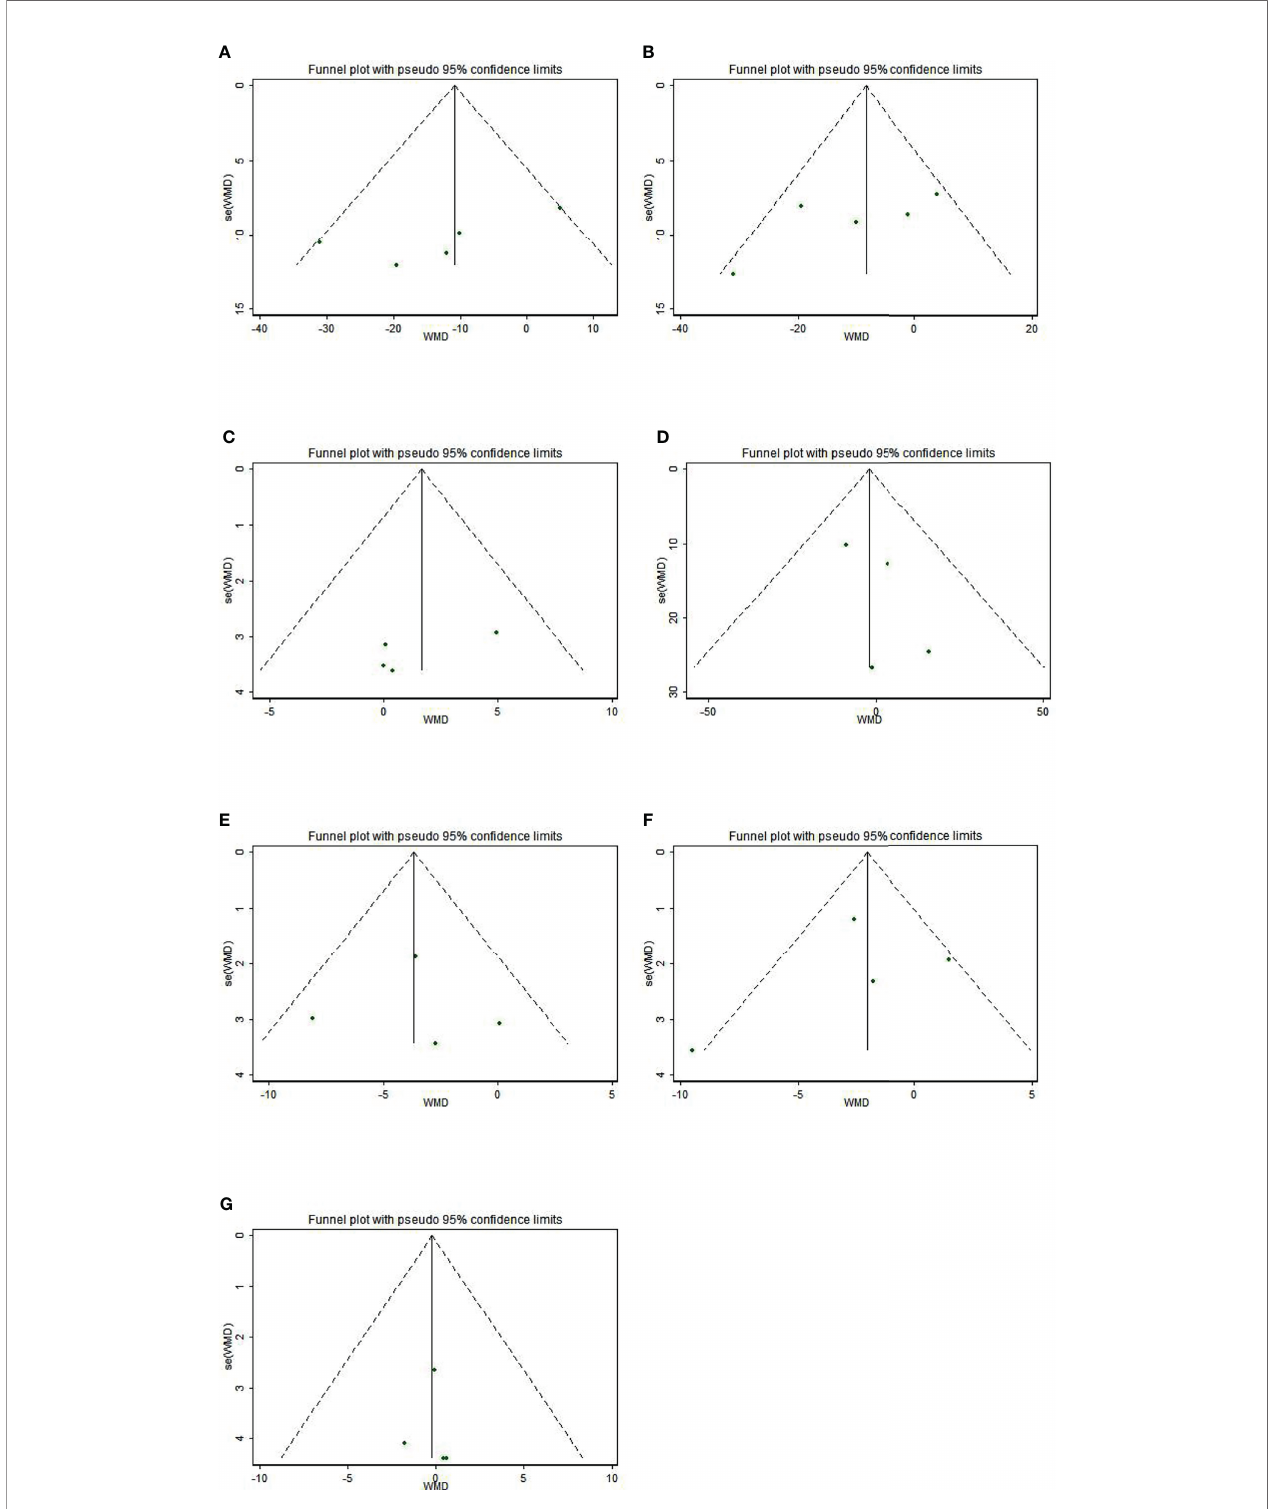
FIGURE 4 | Funnel plot of the effect of sesamin supplementation on TC (A) , LDL-c (B) , HDL-c (C) , TG (D) , SBP (E) , DBP (F) , and weight (G)